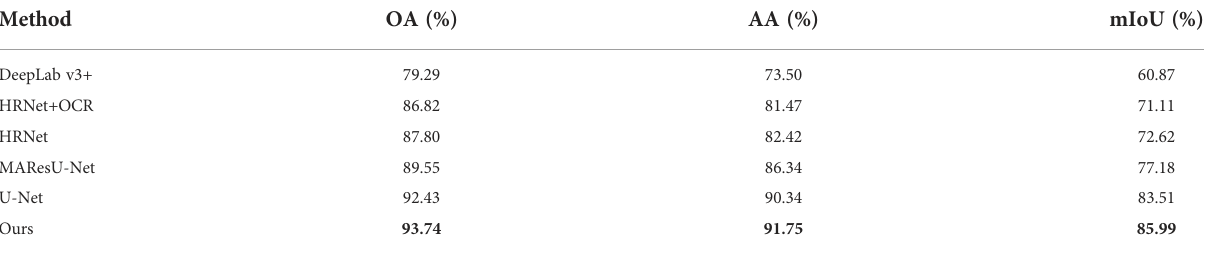
TABLE 3 Contrast experiments with various mainstream state-of-the-art semantic segmentation models.